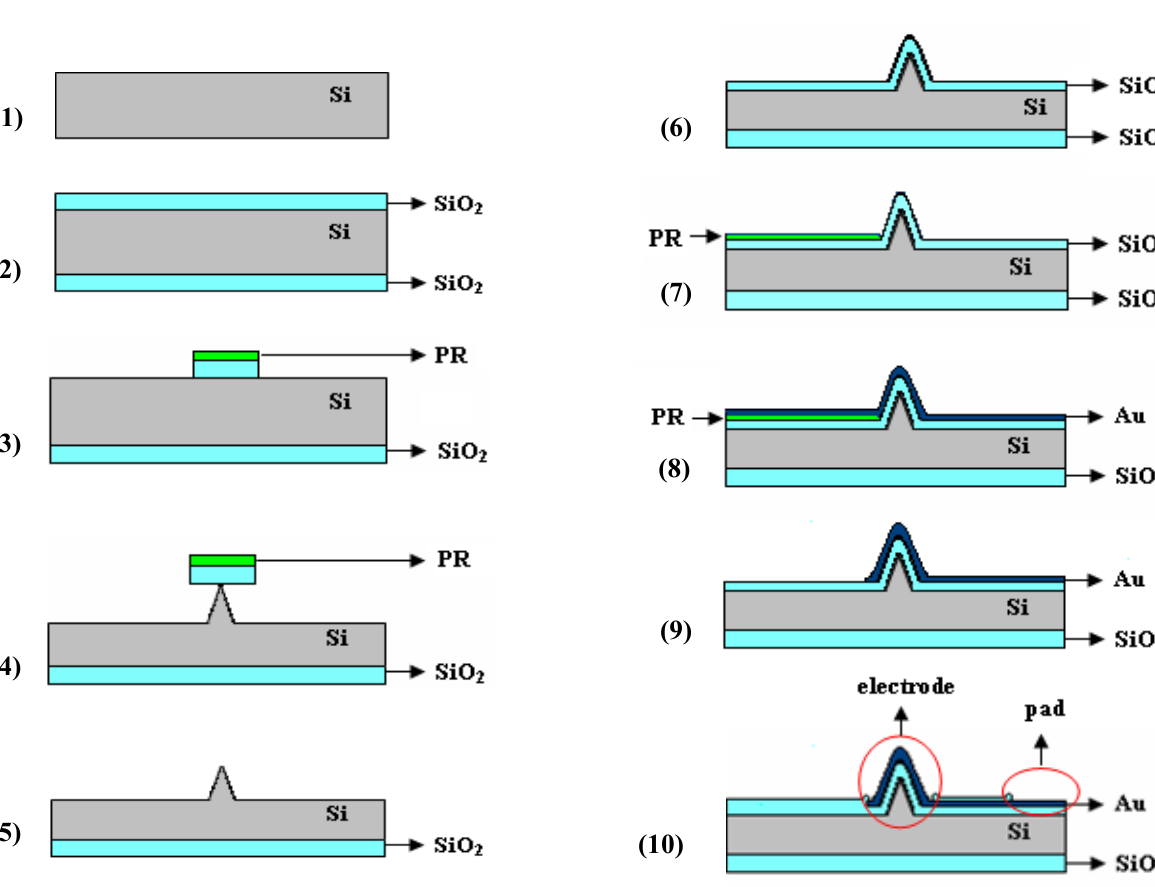
Figure 1. The fabrication process flow for the Si-MEA